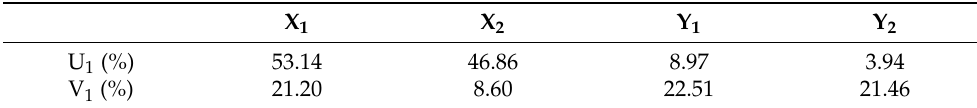
Table 2. Canonical redundancy analyses between U 1 and V 1.